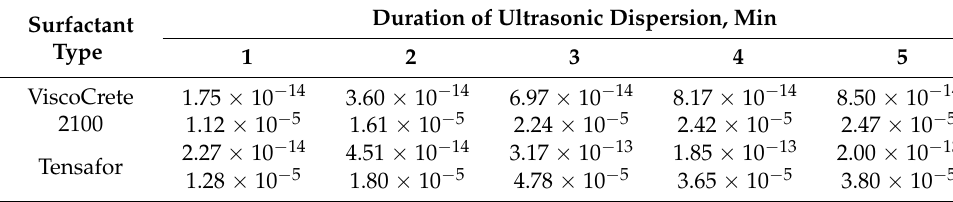
Table 8. Diffusion coefficient and mean displacement distance for the CNPLUS particles in the aqueous solution of the surfactant.